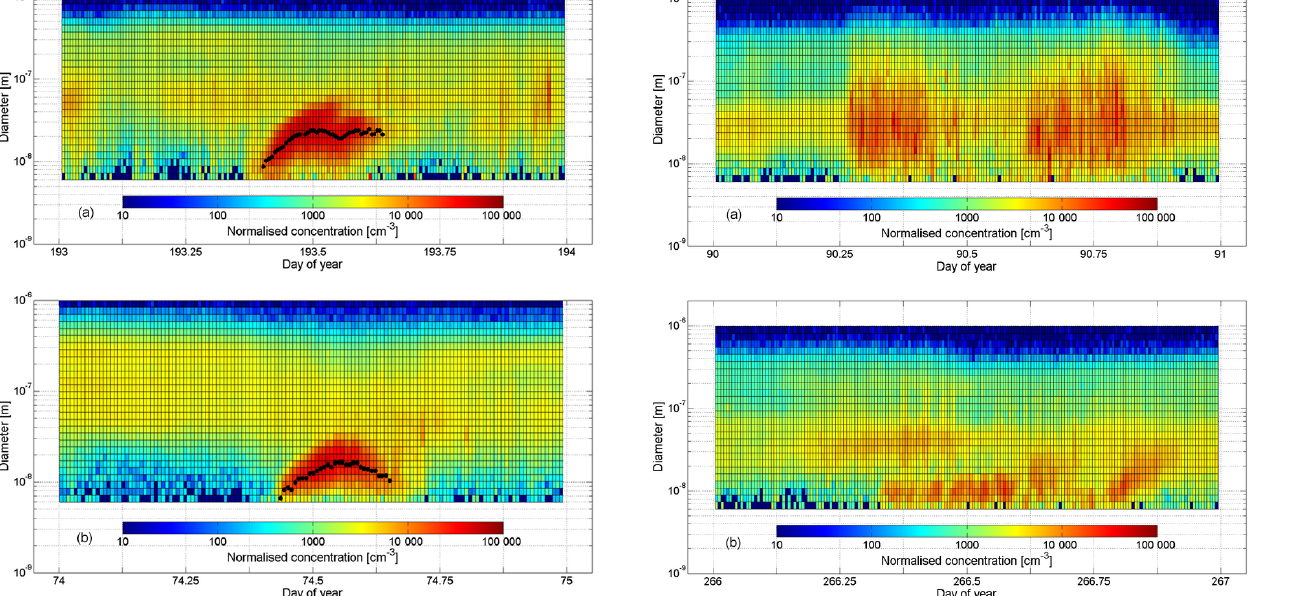
Figure 11. Size distribution surface plots showing the typical effects of vehicular road traffic emission sources and local meteorology (a) in the city centre on Tuesday, 31 March 2015, and of extensive grass cutting in the neighbourhood (b) of the BpART facility on Tuesday, 23 September